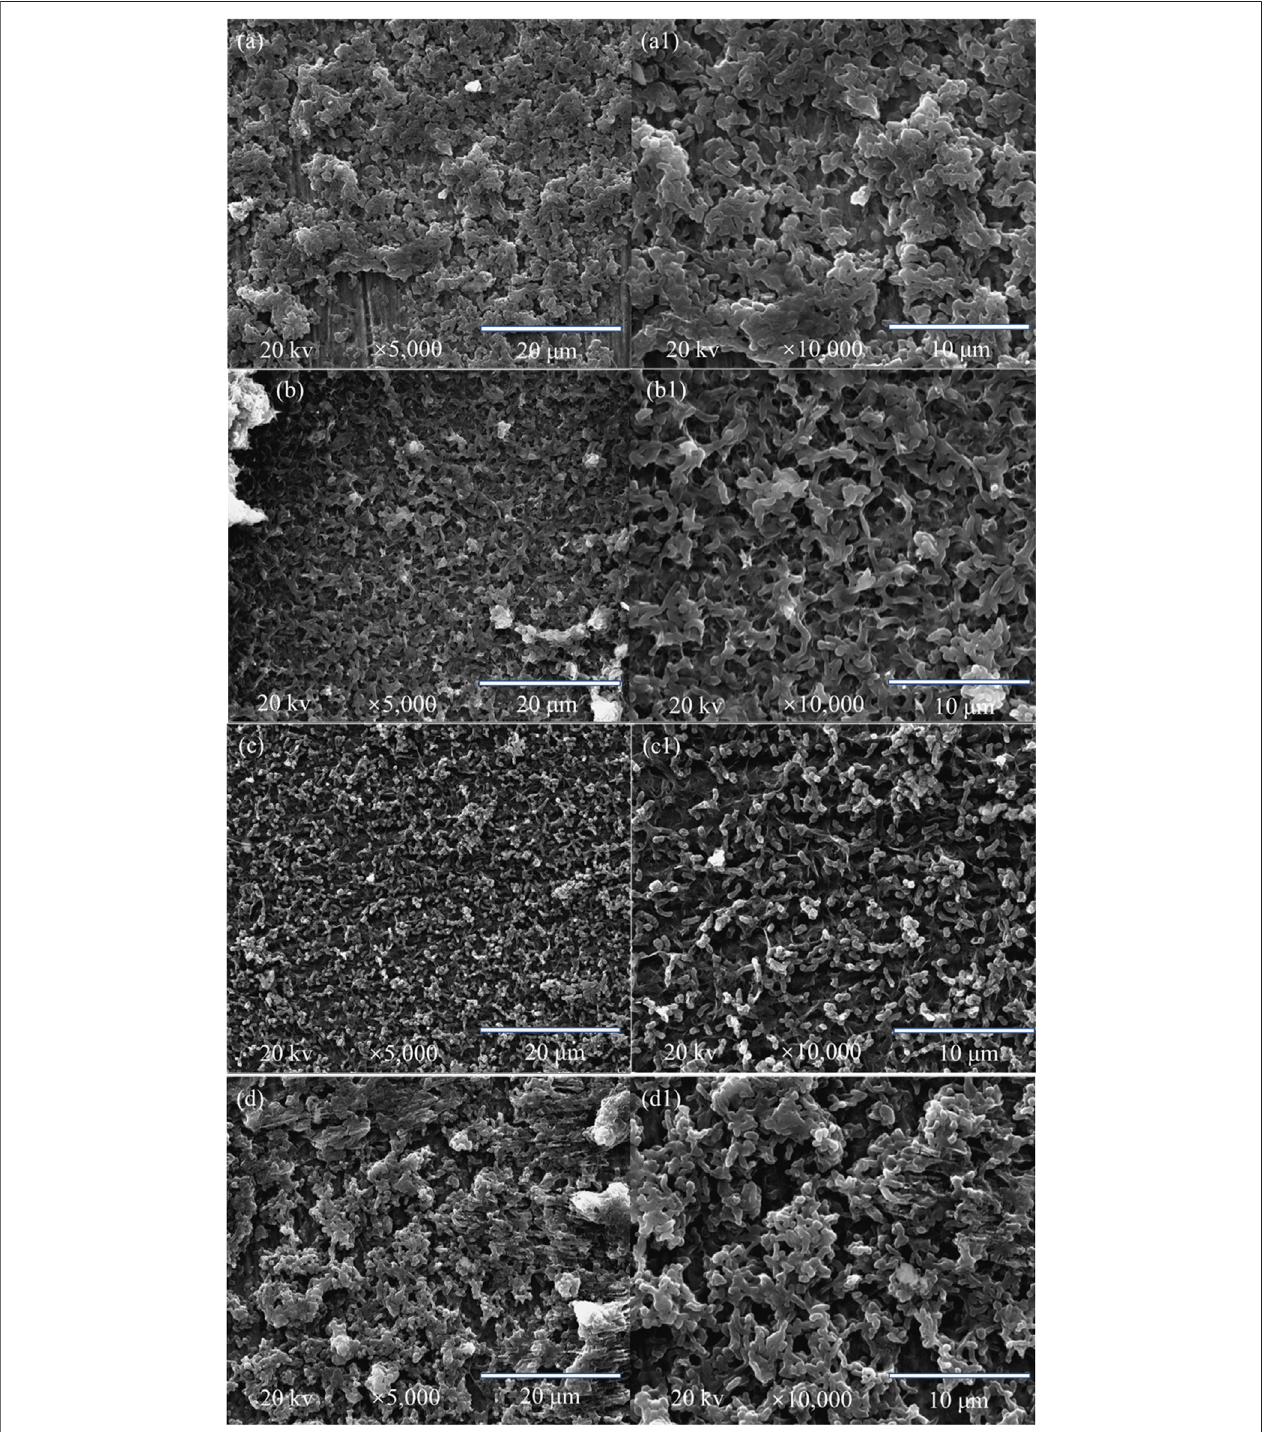
FIGURE3| SEMimagesofthesquarecouponsurfacesafter14-daystarvationincubationinanaerobicvialswith200 mlof D.vulgaris broth,250 mlofheadspace, and carbon source levels of 0% (a,a1) , 10% (b,b1) , 50% (c,c1) , and 100% (d,d1) .